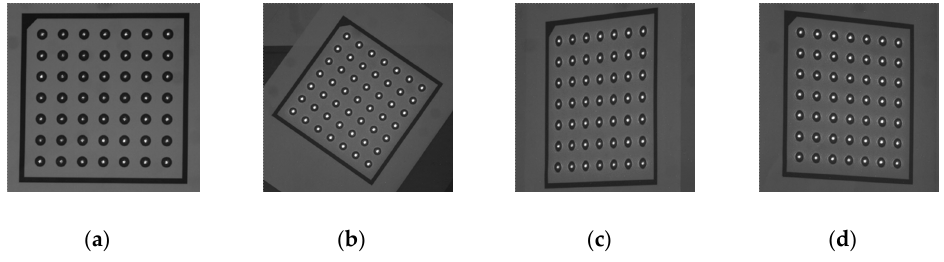
Figure 11. Shooting experiment results with four different poses ( a – d ) at a same distance (2.5 m) from the GLS system. Table 2. Performance measure S d at different shooting distances. ( a ), ( b ), ( c ) and (d) respectively represent the four different poses of the target in 2.5 m.